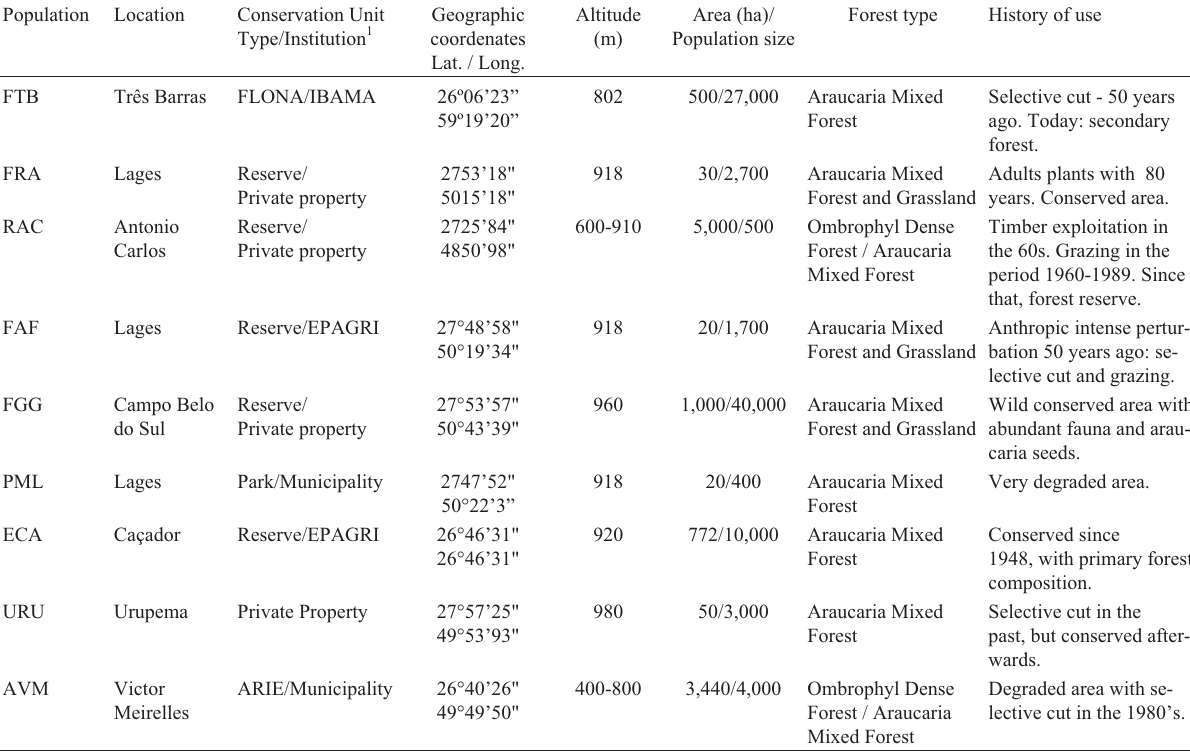
Table I - Geographic location, altitude, area size and population size, forest type, and area history of the nine Araucaria Angustifolia populations. Population